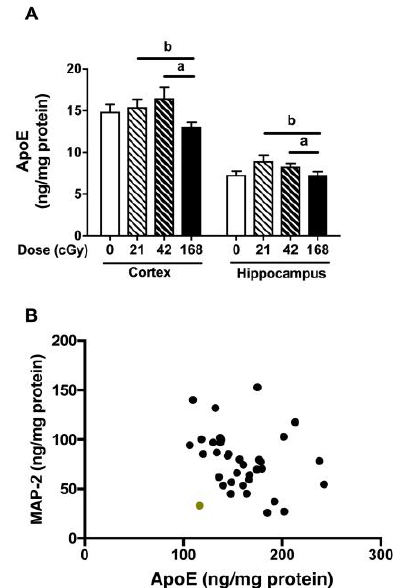
Figure 5. ( A ) ApoE levels in the cortex and hippocampus. There was an effect of irradiation on apoE levels ( F (3,32) = 3.810, p = 0.019, Figure 5A). ApoE levels were higher in mice irradiated with 42 than 168 cGy ( p = 0.035, Bonferroni’s correction for multiple comparisons, indicated by “a” in the figure), and there was a trend towards higher apoE levels in mice irradiated at 21 than 168 cGy ( p = 0.065, Bonferroni’s correction for multiple comparisons, indicated by “b” in the figure). ( B ) Relationship between hippocampal MAP-2 and apoE levels ( r = −0.3277, p = 0.0511, two-tailed Spearman correlation, 36 data points). Inspecting the data, there was one data point that seemed removed from the other ones (indicated in green). Therefore, we also performed the analysis without that data point included. The analysis without that data point revealed: r = −0.4123, p = 0.0138, Spearman correlation, 35 data points.